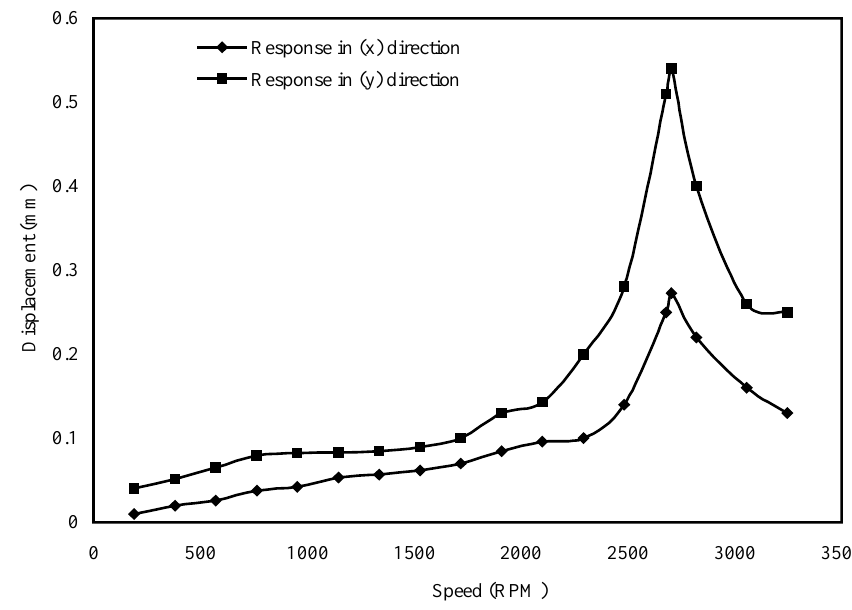
Fig. 6. Speed – displacement relation for simply supported shaft (Mild steel shaft of 0.724 m